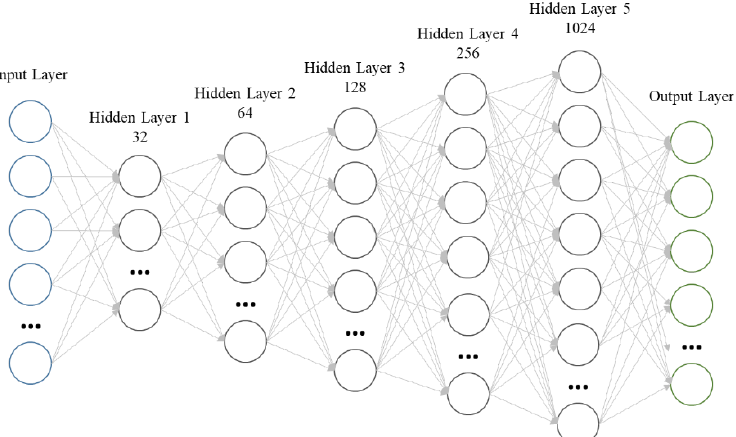
Figure 4. Network architecture implemented for the Deep Neural Network (DNN) model along with the number of neurons that were optimized for each hidden layer. The output layer contains 11 neurons, corresponding to the number of classes to be classified.